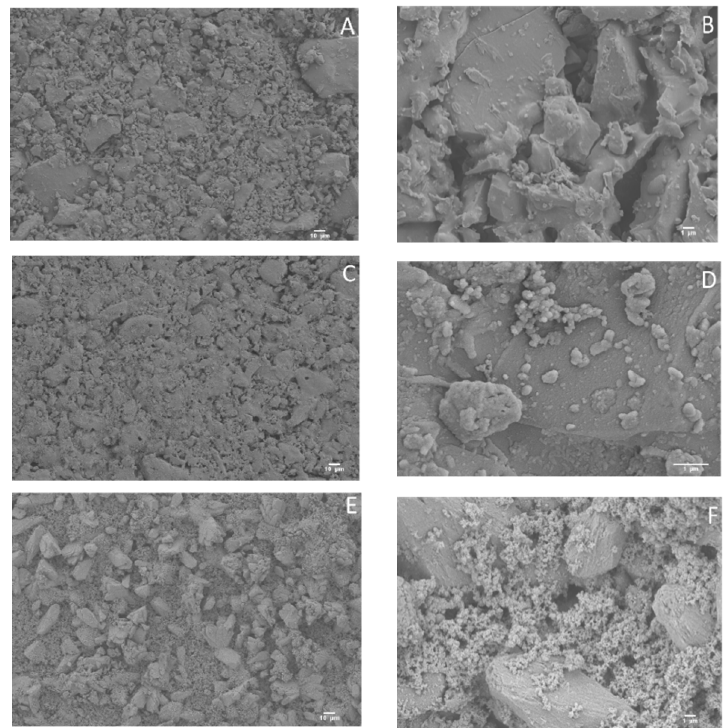
Figure 1. Scanning electron microscopy (SEM) micrographs of uncoated BGC1 ( A, B ), BGC1@PDA ( C, D ), and BGC1@PDA@Ag ( E, F ).